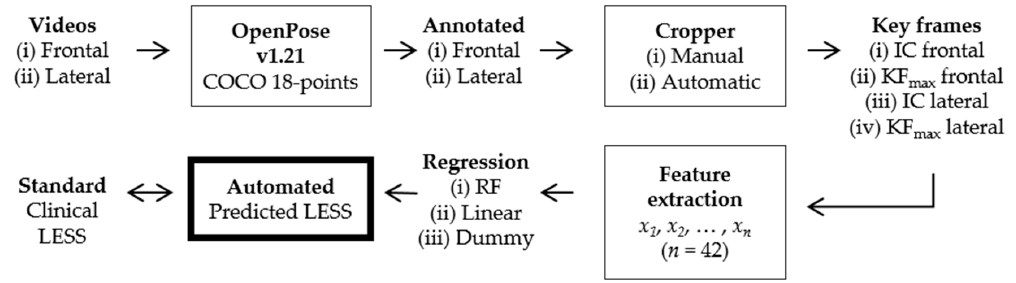
Figure 1. Flow diagram of data processing leading to comparing ‘gold standard’ clinical LESS scores from an expert rater to ‘automated’ predicted LESS scores from the automation process. Abbreviations : IC, initial contact; KF max , maximal knee flexion; LESS, Landing Error Scoring System; RF, random